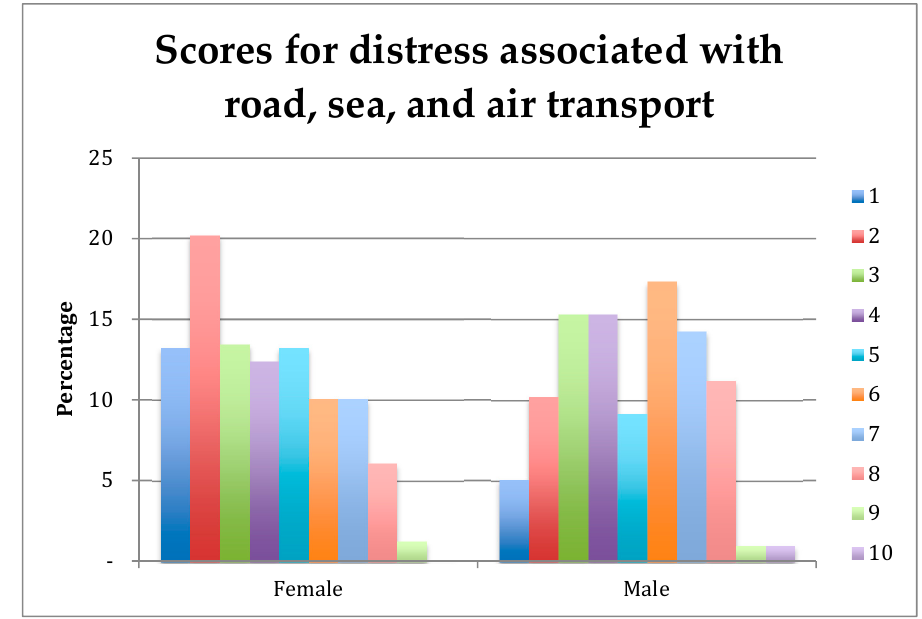
Figure 3. Percentage of female ( n = 671) and male ( n = 145) students rating (1 = extremely important, 10 = least important) of the importance of understanding distress associated with road, sea, and air transport on their first day in practice.